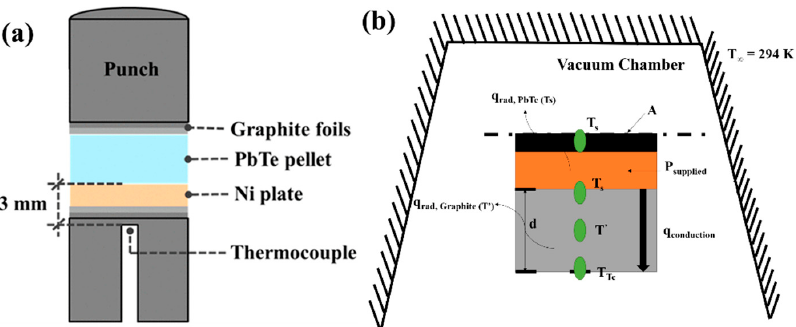
Figure 7. ( a ) Experimental assembly for bonding between PbTe and Ni solids (reproduced with permissions from reference [46]), and ( b ) One-dimensional thermal model for the bonding process of current assembly in the SPS (Concept adapted and redrawn from [46]).